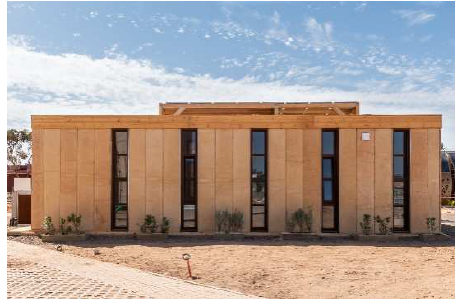
Figure 2. The case study building.